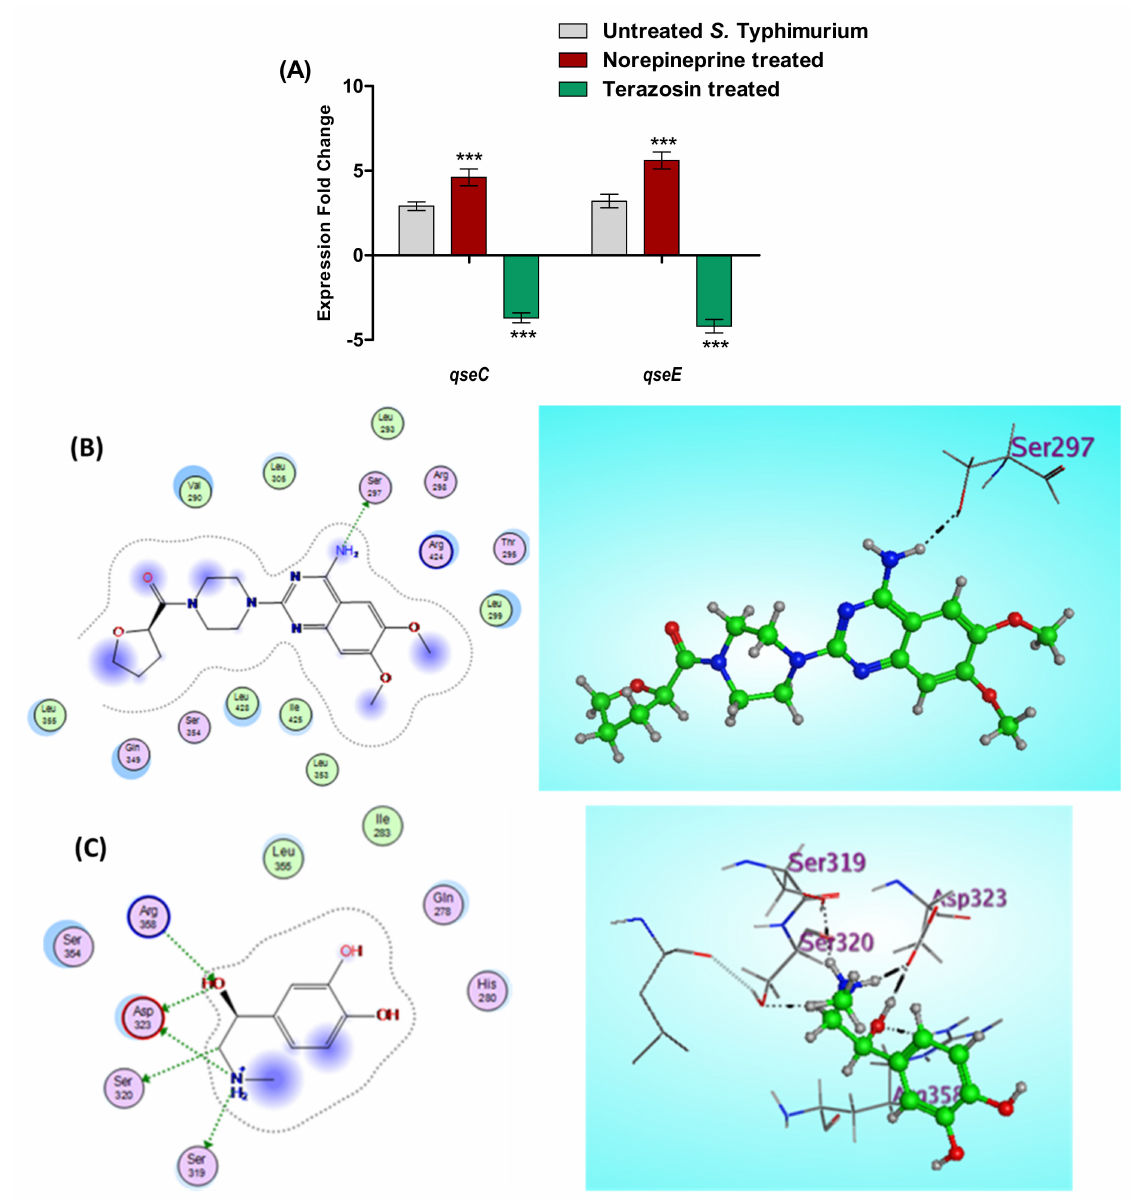
Figure 8. Terazosin interferes with adrenergic hormone sensors. ( A ) Terazosin